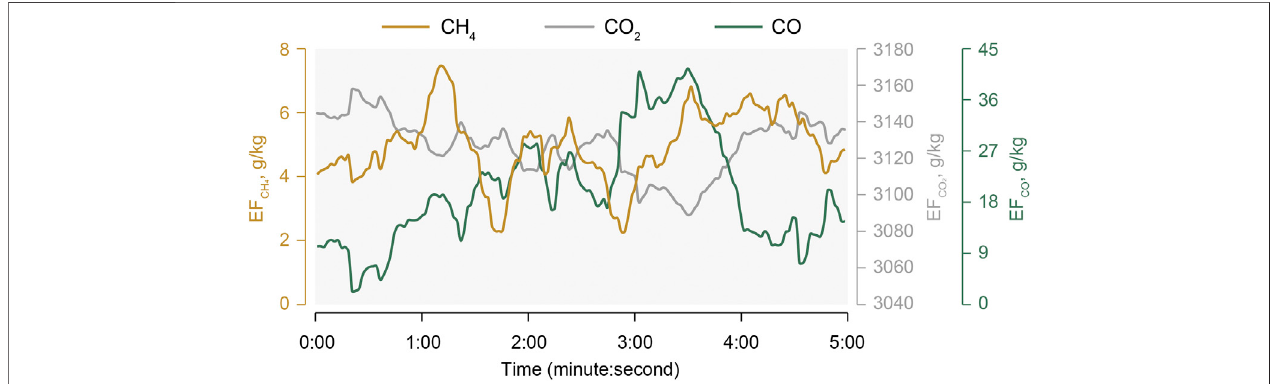
FIGURE 1 | The measured temporal variation in instantaneous EF CH4 , EF CO2 , and EF CO of a typical OSFV during